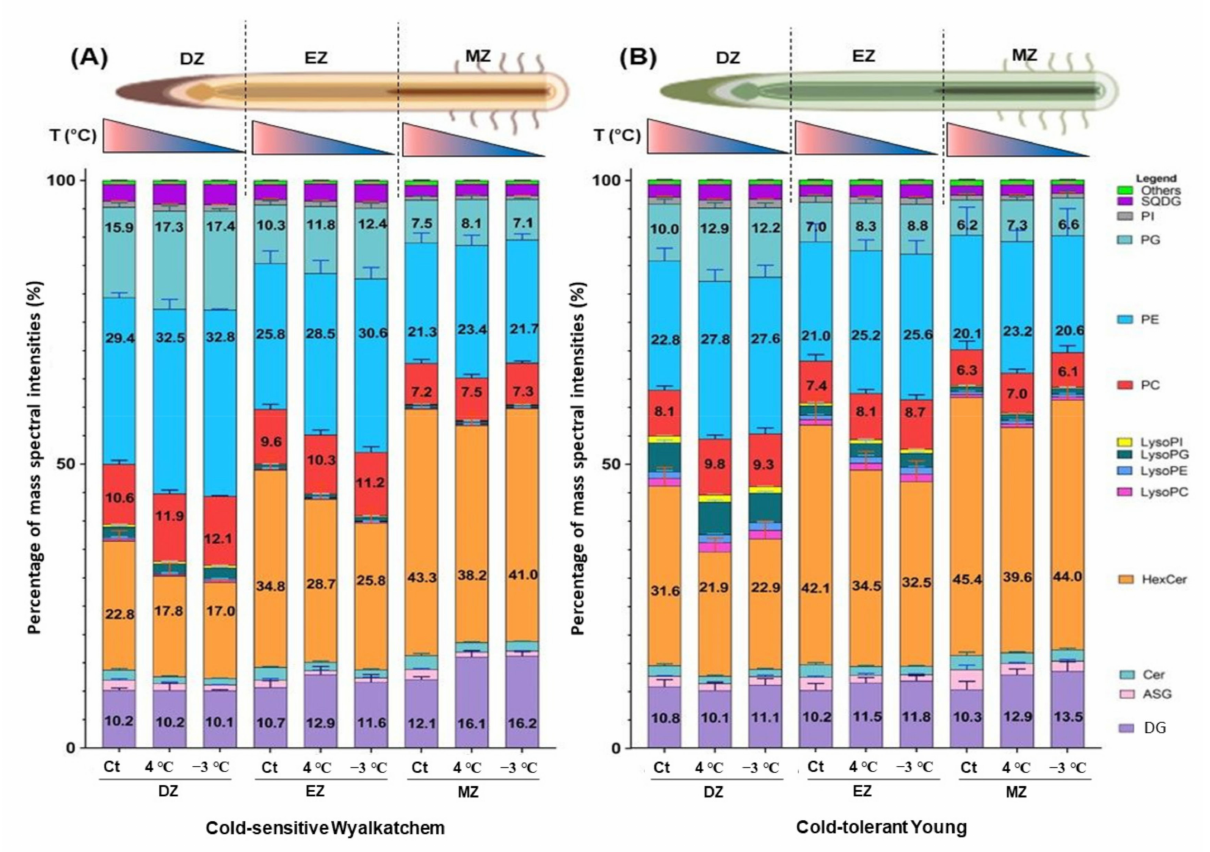
Figure 2. The distribution of the 21 measured lipid classes (in percentage of mass spectral intensity, %) in each specific root zone of ( A ) cold-sensitive Wyalkatchem and ( B ) cold-tolerant Young at the un- stressed stage (21 ◦ C) and after subjected to chilling (4 ◦ C) and freezing ( − 3 ◦ C) stress. DZ = division zone, EZ = elongation zone, MZ = maturation zone, Ct = control (21 ◦ C). Others (light green colour) in the legend represent lipid classes PS, LysoPS, DGDG, DGMG, MGDG, MGMG, SQMG, and SG that in total occupied less than or equal to 1% of the